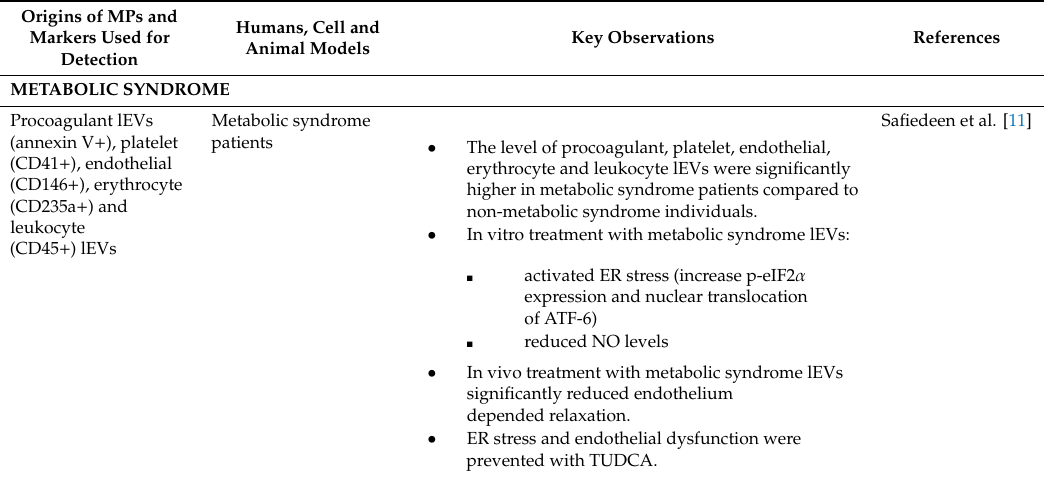
Table 4. Summary of the main studies of altered lEV (MP) levels and their associated e ff ects on metabolic syndrome in human, in vitro and animal